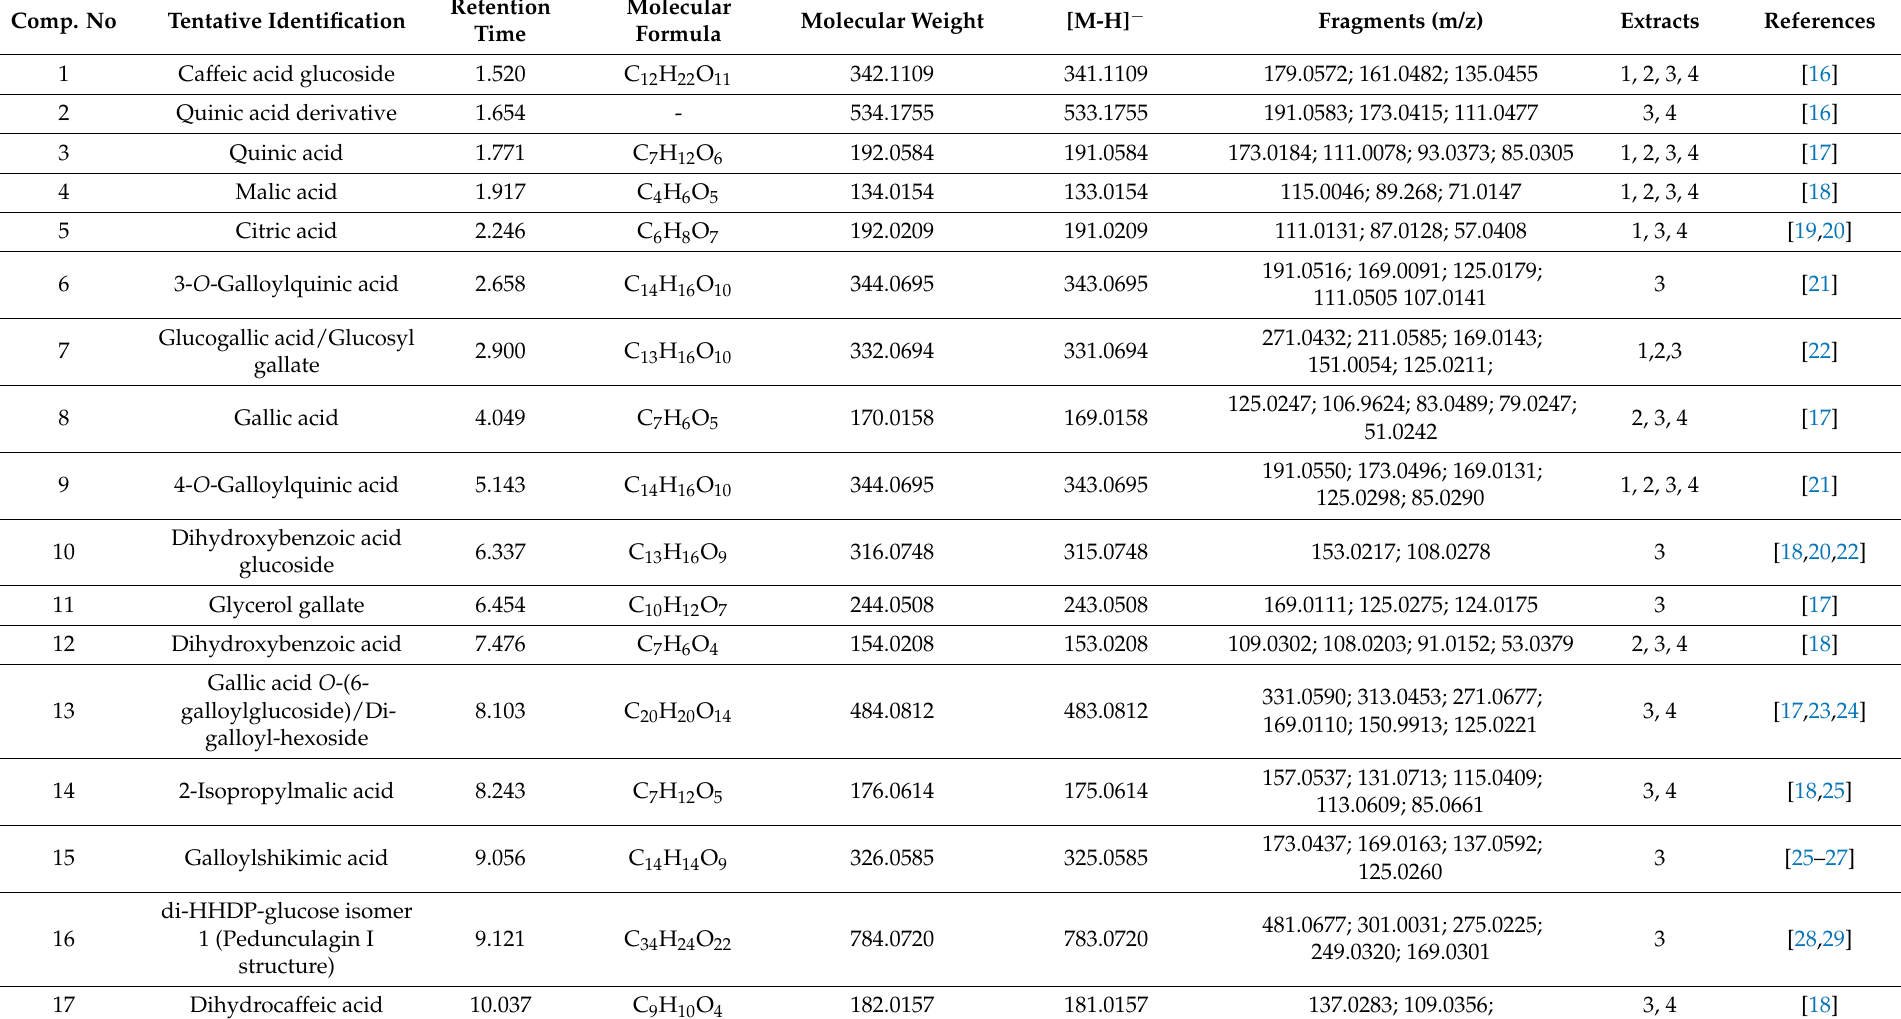
Table 2. Chemical composition of the tested